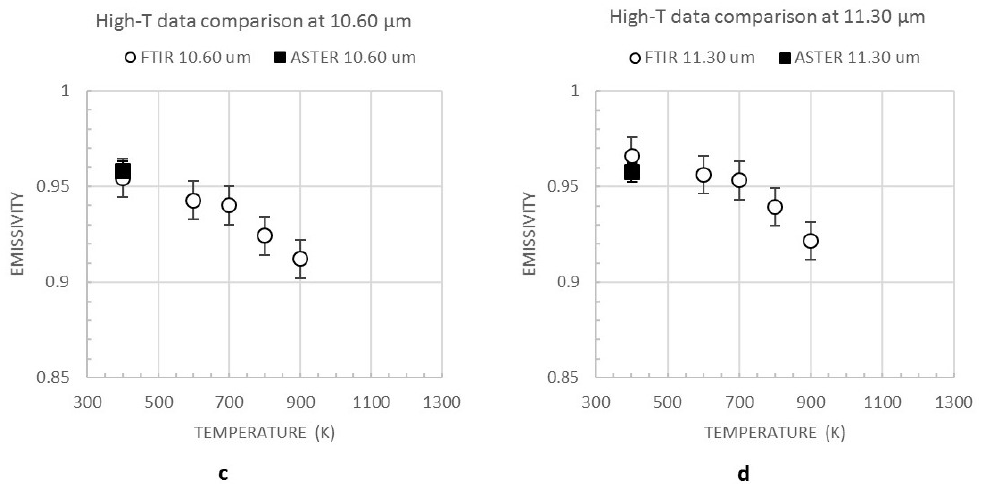
Figure 5. ( a ) ASTER GED mean emissivity values (black squares) plotted at ASTER TIR bands for NRE.4S; ( b ) ASTER GED mean emissivity values (black squares) compared to the ‘apparent’ (1- R ) emissivity (grey triangles) and ‘true’ low-temperature (400 K) emissivity data (empty circles) for NRE.4S; ( c , d ) ASTER GED mean emissivity (static) for NRE.4S (black square) at 10.60 µ m and 11.30 µ m (ASTER TIR bands 4 and 5 respectively), superimposed on the emissivity/temperature trend 400–900 K (empty circles). Error bars represent maximum emissivity difference between NRE.4S samples